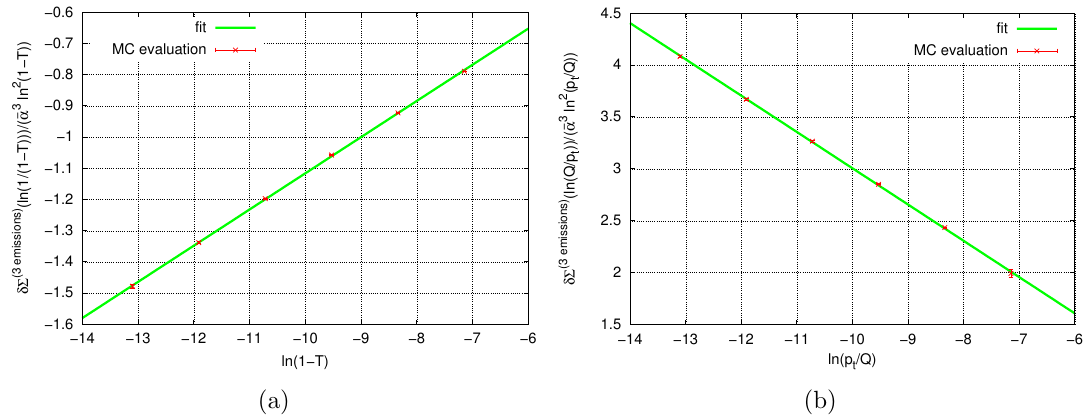
Figure 6. Di(cid:11)erence between the third-order expansion of the dipole showers considered in this manuscript and the correct result obtained from analytic resummation at NLL, both for thrust (6a) and for the vectorial p t sum (6b). The data points correspond to the Monte Carlo result, divided by (cid:22) (cid:11) 3 L 2 so that a term proportional to (cid:22) (cid:11) 3 L 3 appears as a straight line, while the solid line is the resulting (cid:12)t in the L 2 [ (cid:0) 14 ; (cid:0) 6]